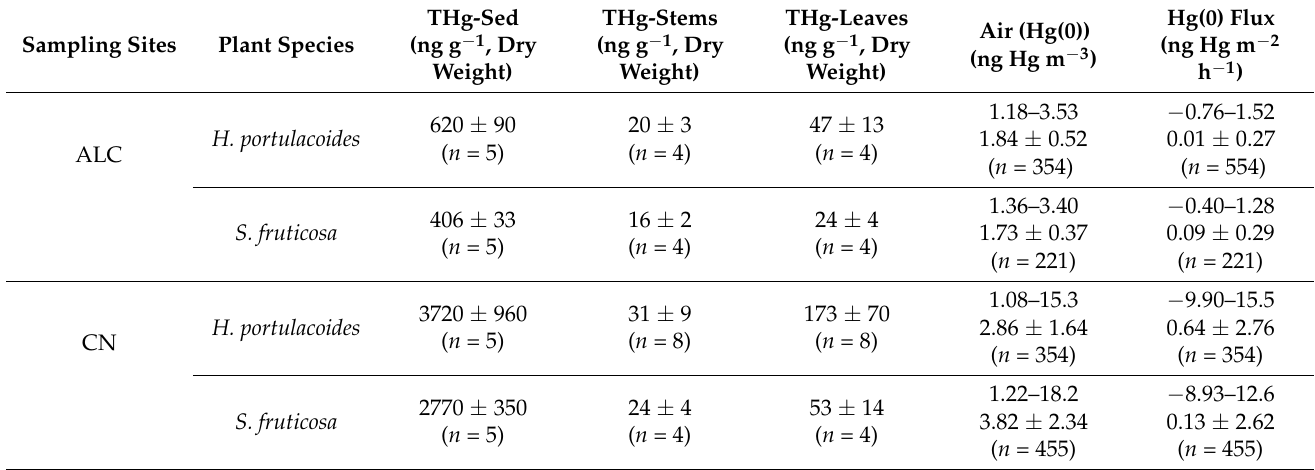
Table 1. Average total Hg concentrations (ng g − 1 , dry weight) in surface sediments and aboveground plant parts (stems and leaves), ambient Hg(0) concentrations (ranges and Avg ± SD in ng Hg m − 3 ), and vegetation-to-air Hg(0) fluxes (ranges and Avg ± SD in ng Hg m − 2 h − 1 ) obtained at each saltmarsh area, colonized by H. portulacoides and S. fruticosa , during the DFC experiments in ALC (“background” site) and in CN (industrial